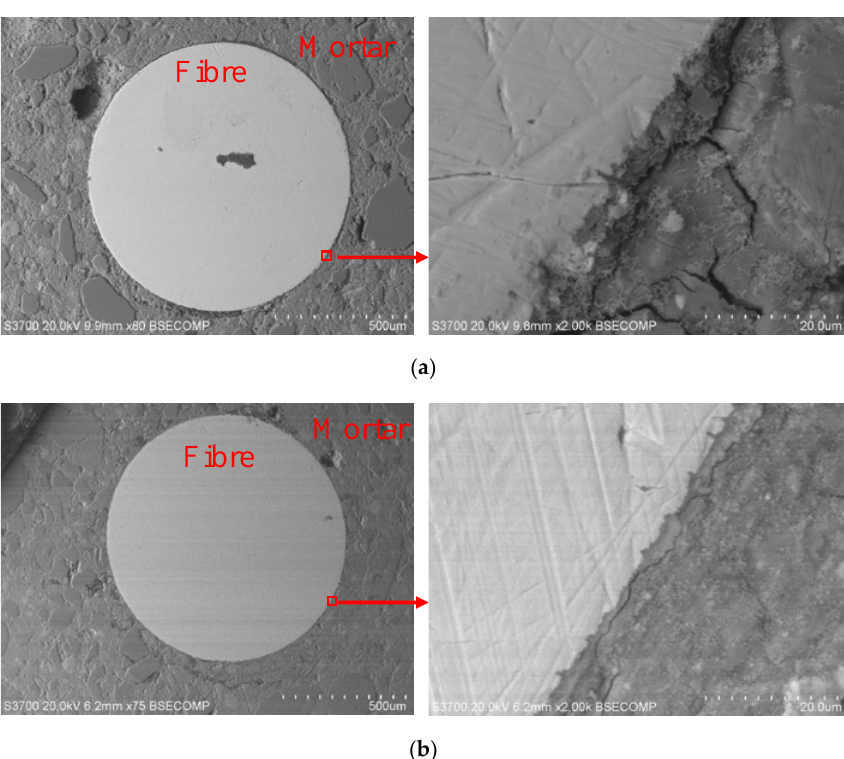
Figure 12. SEM micrographs of the ITZs: ( a ) An untreated fibre; ( b ) A fibre treated with Z6011 (group Z1).